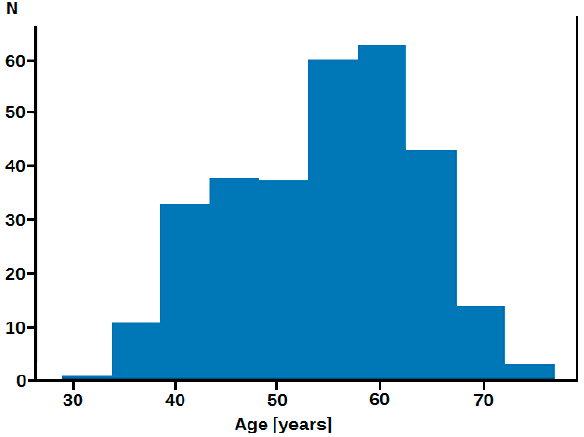
Figure 3. Distribution of patients’ age (N = 303, aged 54.37 ± 9.08).